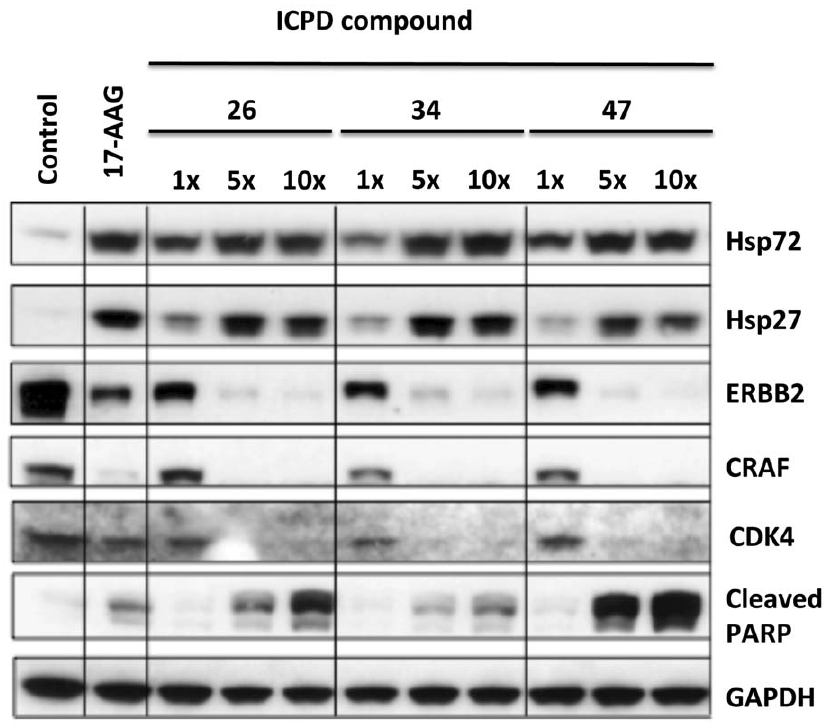
Figure 4. The biomarker signature of Hsp90 inhibition. Western blot showing depletion of Hsp90 client proteins and induction of Hsp72, Hsp27 and cleaved PARP, upon treatment with 1 6 , 5 6 and 10 6 GI 50 concentrations of compounds in HCT116 human colon cancer cells for 24 hr. 17- AAG was used as a positive control. Gapdh was used as loading control. Induction of cleaved PARP is also shown and is indicative of apoptosis.